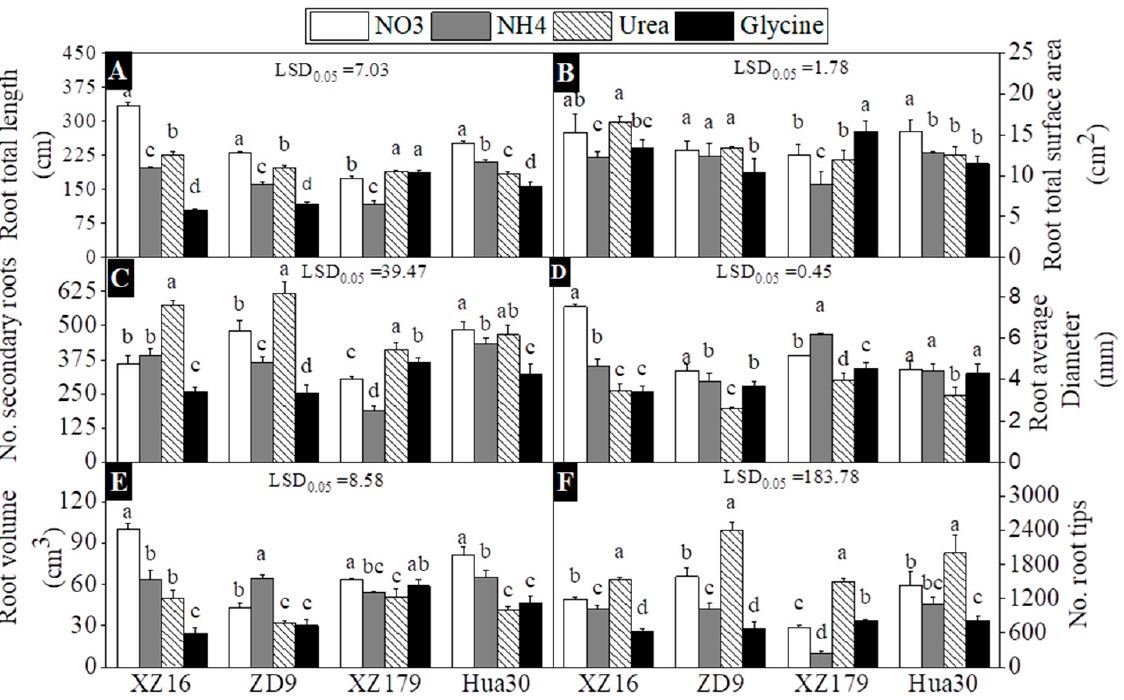
Figure 2. Effects of different nitrogen forms on root growth parameters Total root length ( A ) , total root surface area ( B ), numbers of secondary roots ( C ), Root average diameter ( D ), Root volume ( E ), and Numbers of root tips ( F ) of four barley genotypes at 28 days after treatment (stage 4 and day 42 on BBCH scale). Values are expressed as mean ± SD ( n = 4). Significant difference ( p < 0.05) between treatments is indicated by different letters. LSD.05 values in the figures are for the comparison between genotypes.